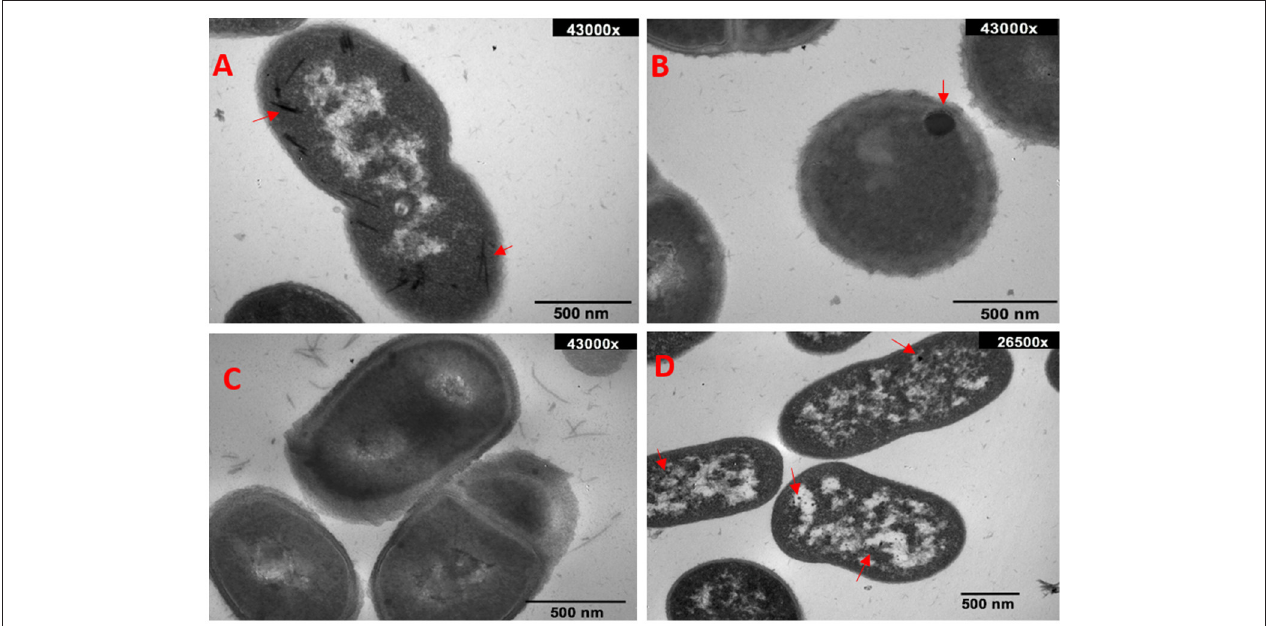
FIGURE 4 | Electron micrographs of in vivo synthesized NS. TeNS, SeNS, AgNS, and AuNS synthesized in vivo by MF09 (A) , MF02 (B) , MF03 (C) , and MF09 (D) ,